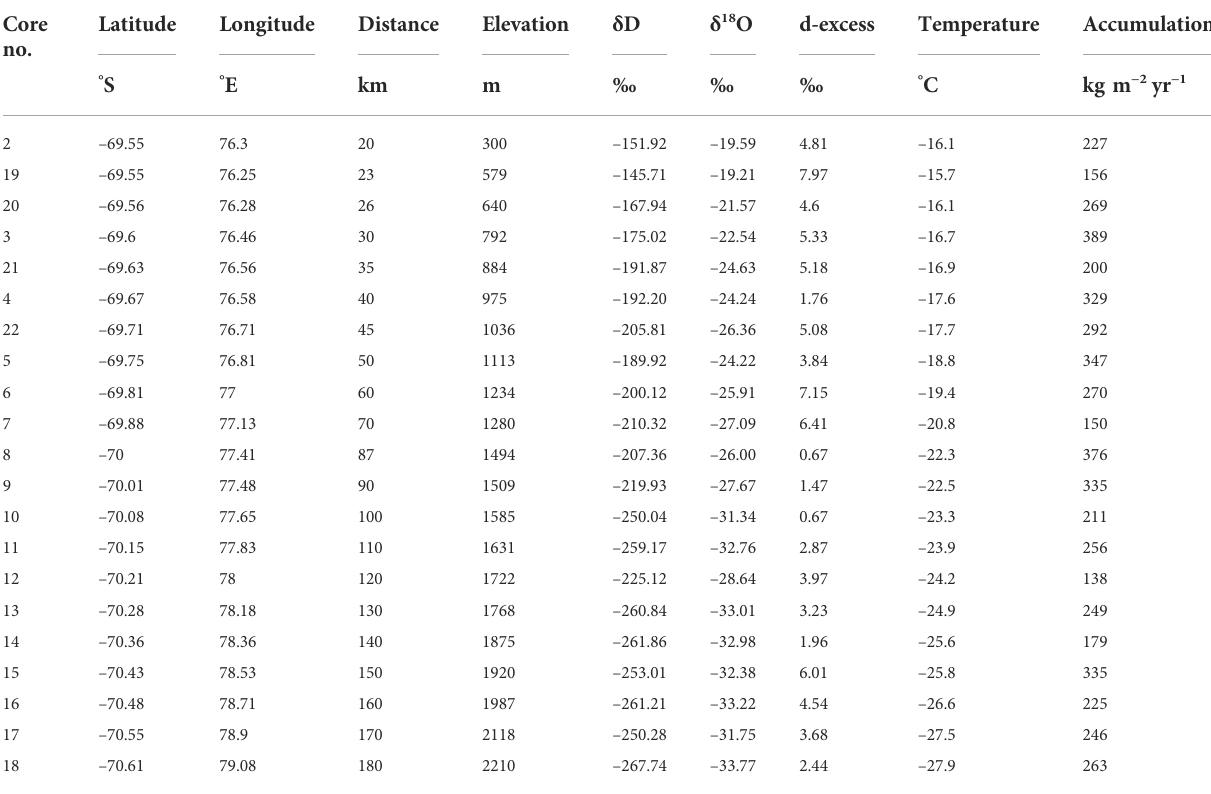
TABLE 2 Geographical distribution and annual-averaged stable isotope values and accumulation rates (w.e) of the snow cores from PEL region. Annually averaged temperature estimates for the year 2008 was taken from ERA-5. The distance column shows the distance measured from the coast. Core